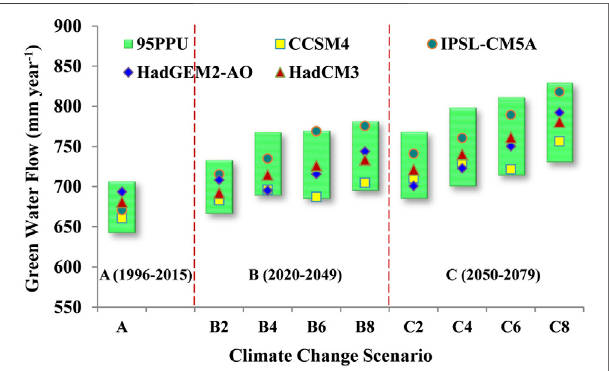
FIGURE 6 | Annual average green water fl ow in different climate scenarios in the Xiangjiang River Basin.